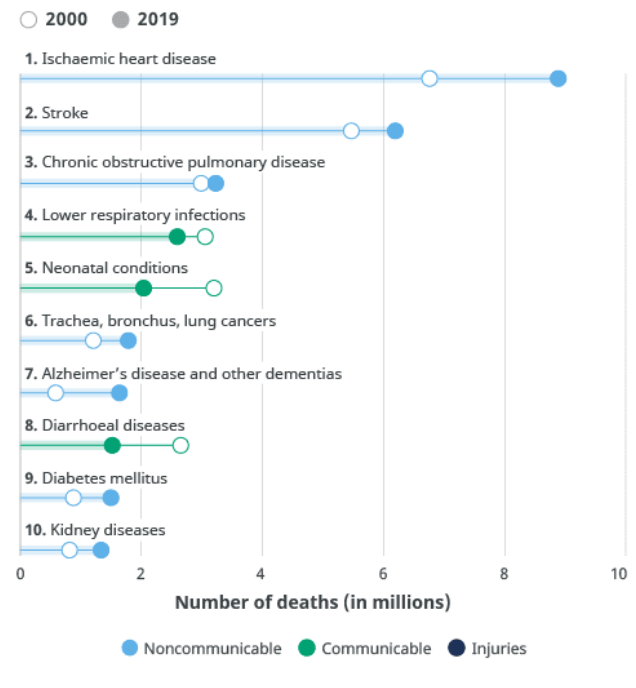
Figure 1. Top 10 causes of death [11].